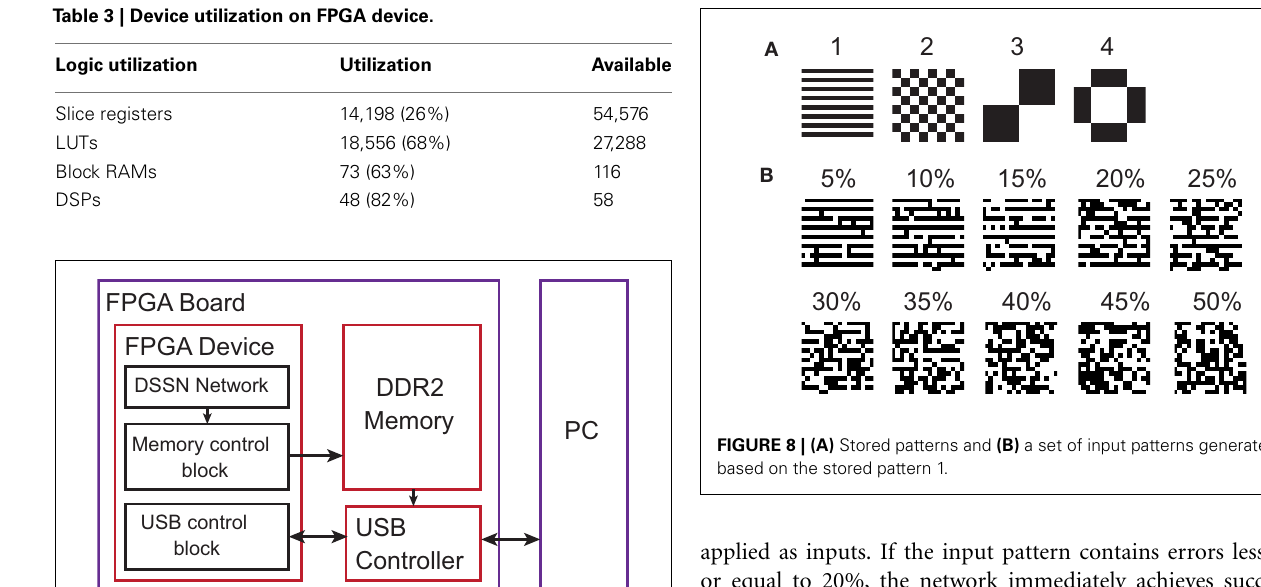
applied as inputs. If the input pattern contains errors less than or equal to 20%, the network immediately achieves successful memory retrieval ( M 1 = 1) and maintains the retrieved pattern for the remaining time. If overlaps stabilize, the state of the network is assumed to be a steady state. In this state of the net- work, the stored pattern is exactly retrieved on each firing cycle ( Figures 10A,B ), and the PSI reaches unity, which indicates that the neural activities are fully synchronous( Figures 10F,G ). When the input pattern contains 30% errors ( Figure 10C ), the over- lap M 1 transiently increases to unity at the beginning and then decreases to M 1 ≈ 0.8538 around 0.19275 s, and the PSI also tran- siently increases to unity and then decreases according to the changes in the overlap ( Figure 10H ). When the errors are